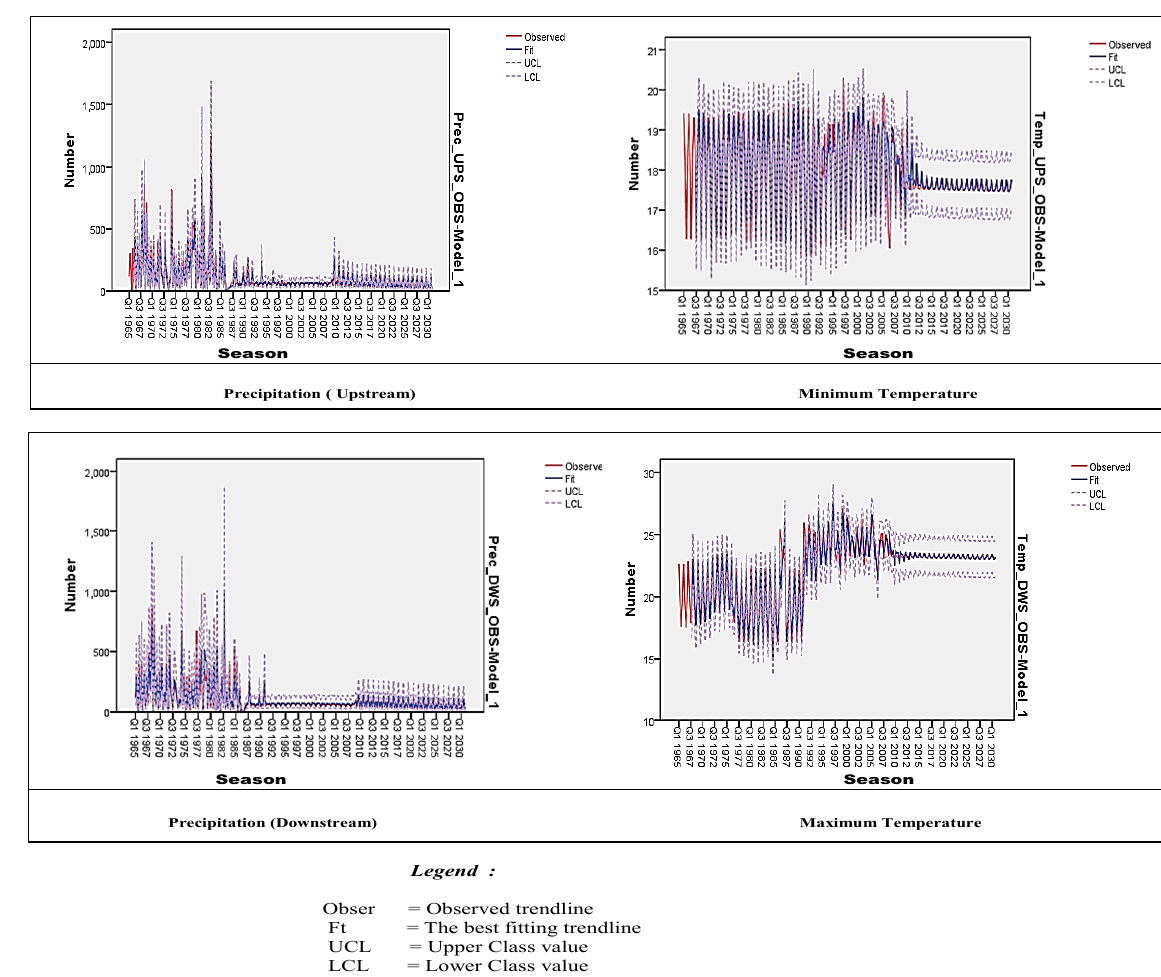
Figure 3. The general trend of observed and expected hydro-climatic variables in